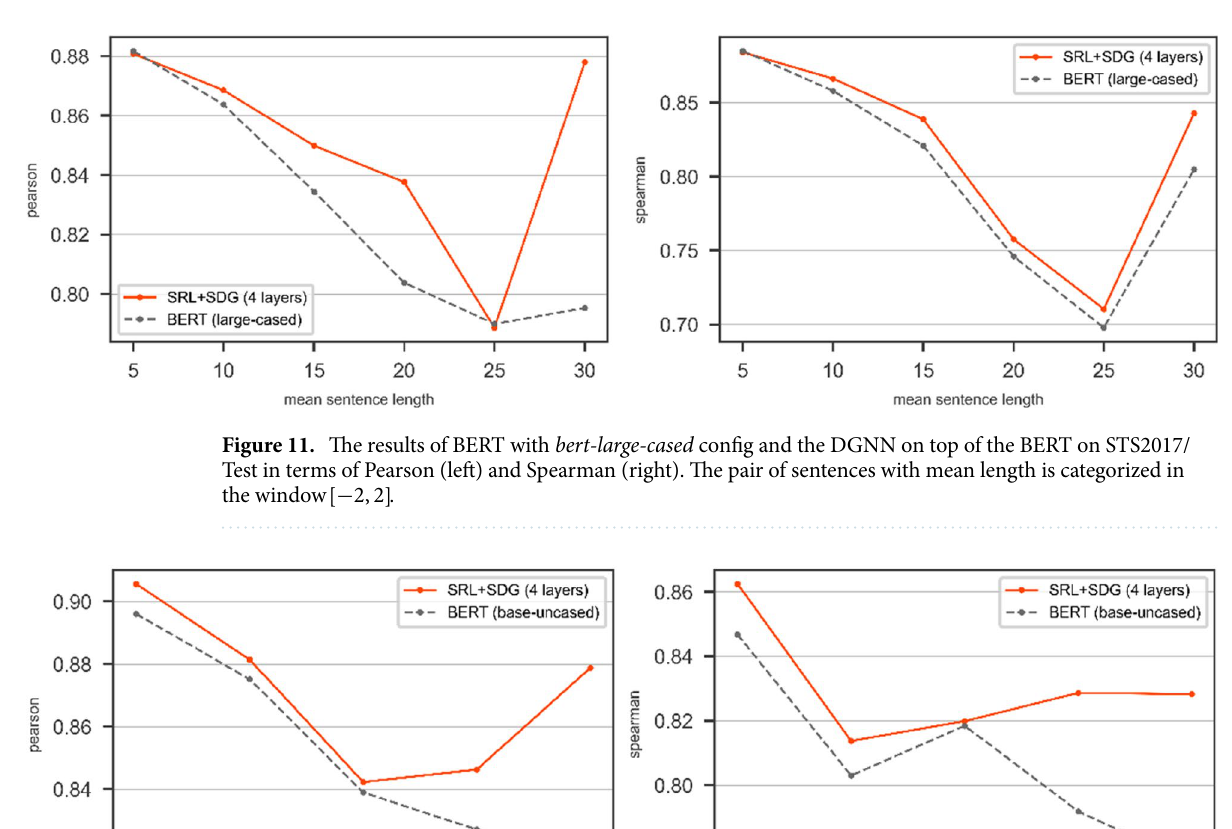
Figure 10. The results of BERT with bert‑large‑cased config and the DGNN on top of the BERT on SICK/Test in terms of Pearson (left) and Spearman (right). The pair of sentences with mean length is categorized in the window [ − 2, 2] .